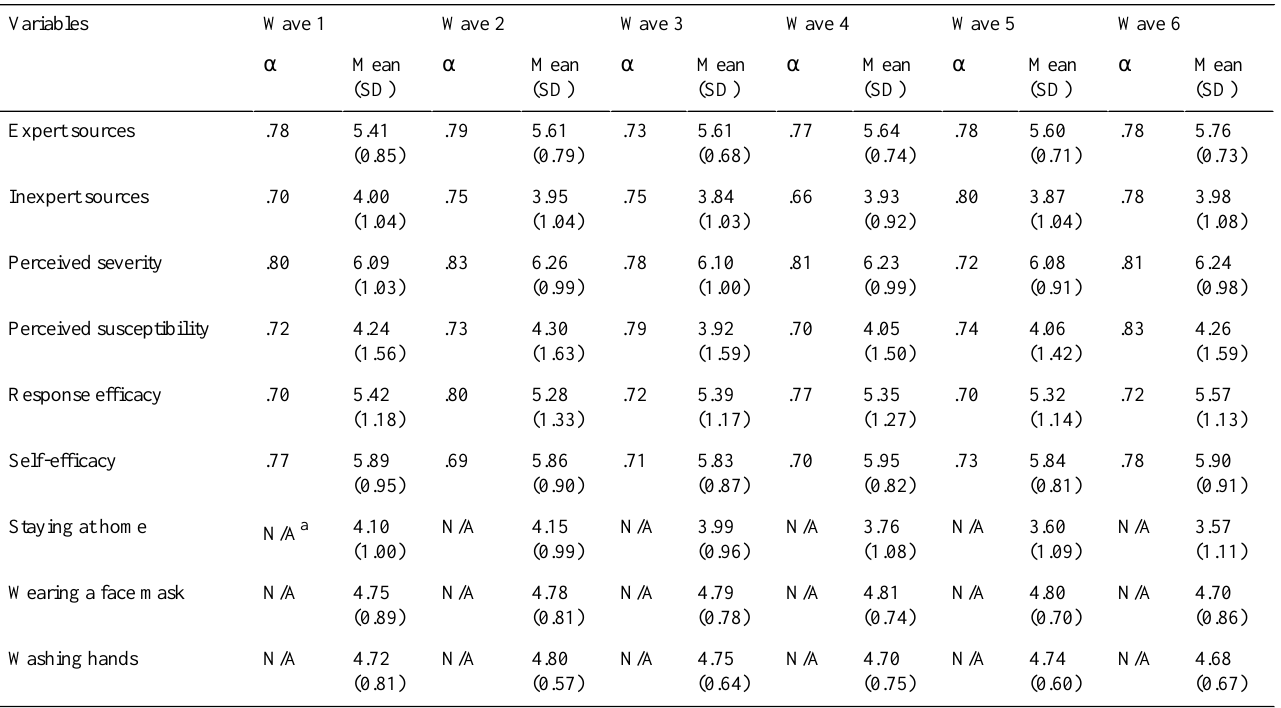
Table 2. Cronbach alpha, means, and SDs of major